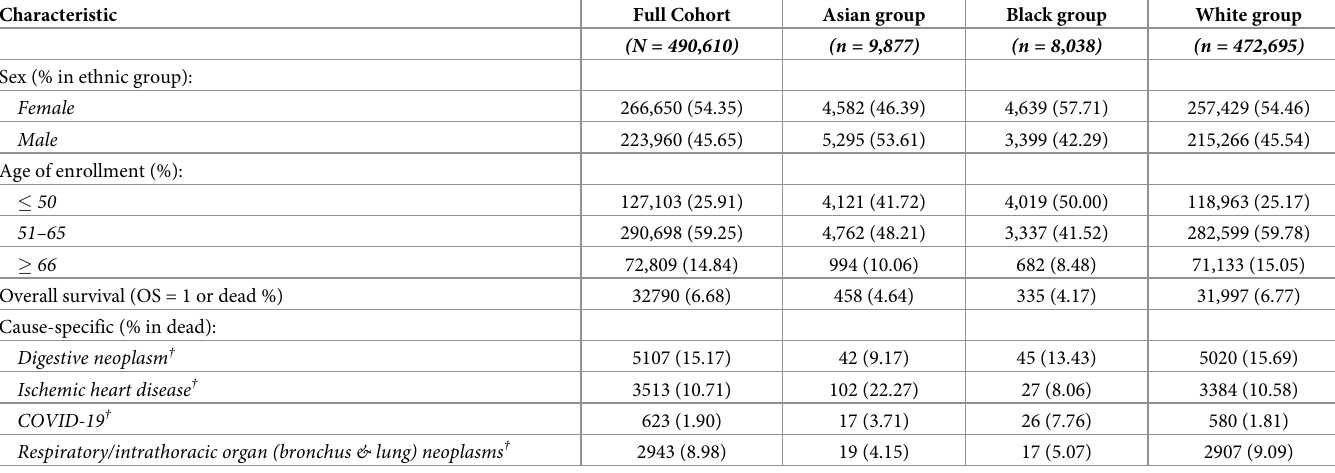
Table 1. Characteristics of the three ethnic group study cohorts in the UK Biobank